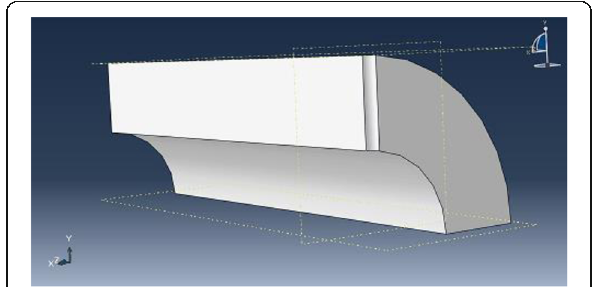
Fig. 2 Selected profile of the model